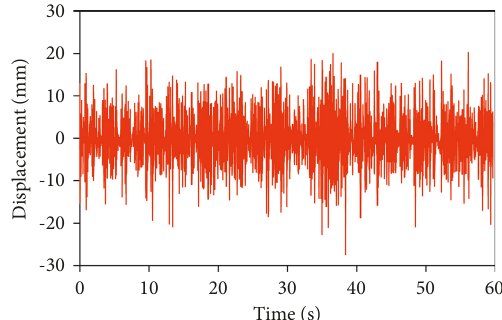
Figure 5: The displacement of the random signal.